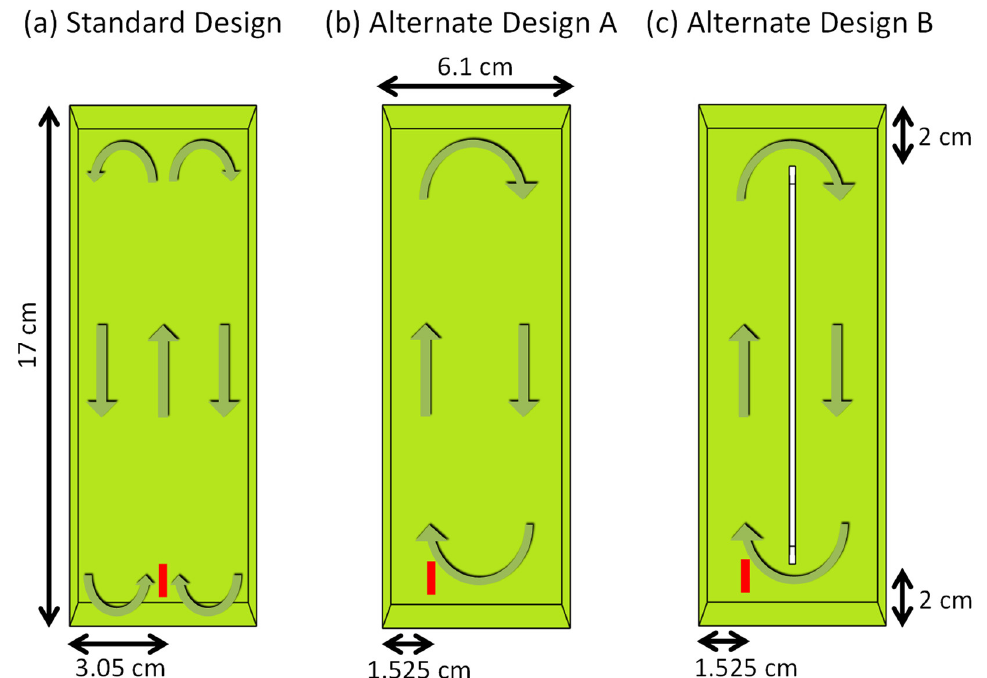
Figure 3. Schematic side view of the three photo-bioreactor designs investigated in this study: ( a ) Standard Design with gas inlet tube in the middle; ( b ) Alternate Design A with inlet moved to front; ( c ) Alternate Design B with additional separating plate. Green arrows indicate directions of main fluid movement, red bars show the positions of gas inlet tubes. The width of all three reactors is 10 cm.